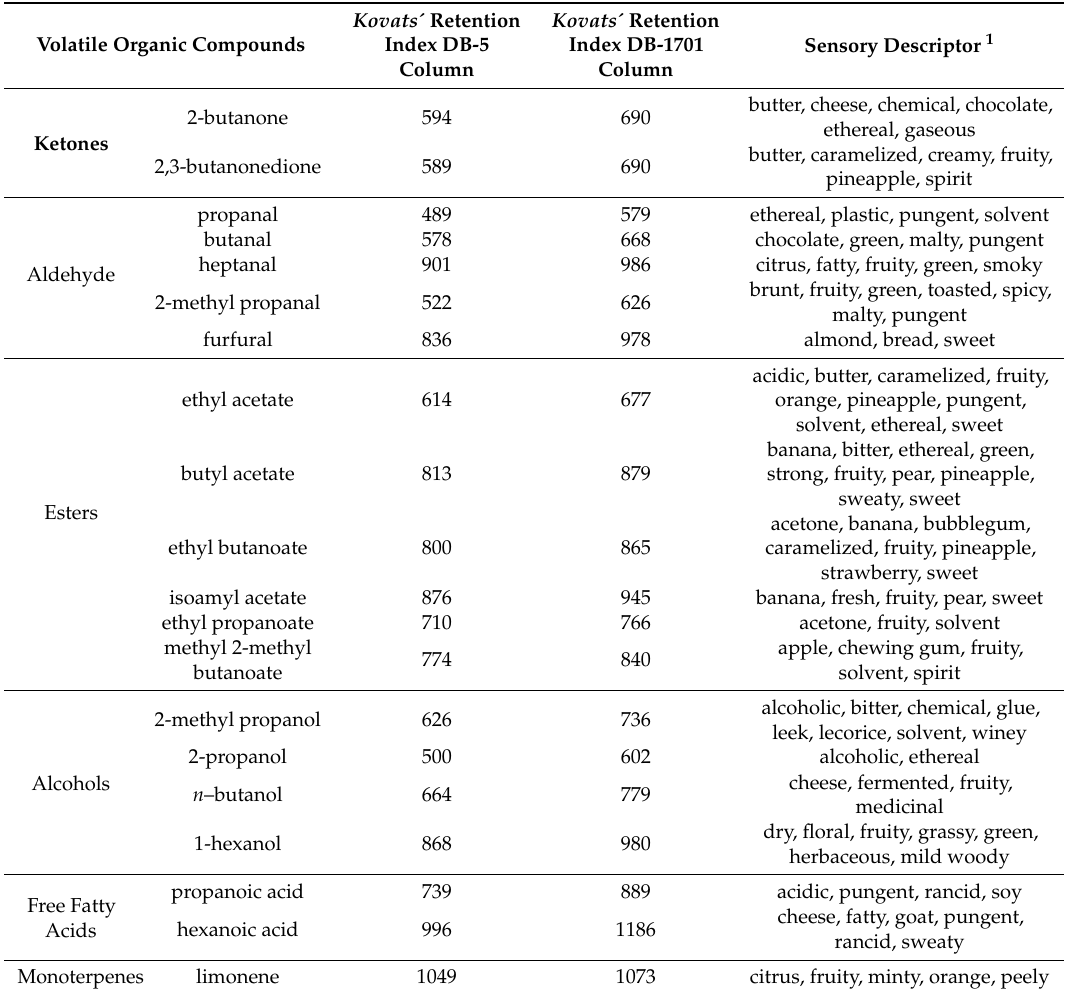
Table 4. Volatile organic compounds in bryndza cheese determined by electronic nose (e-nose) with D >